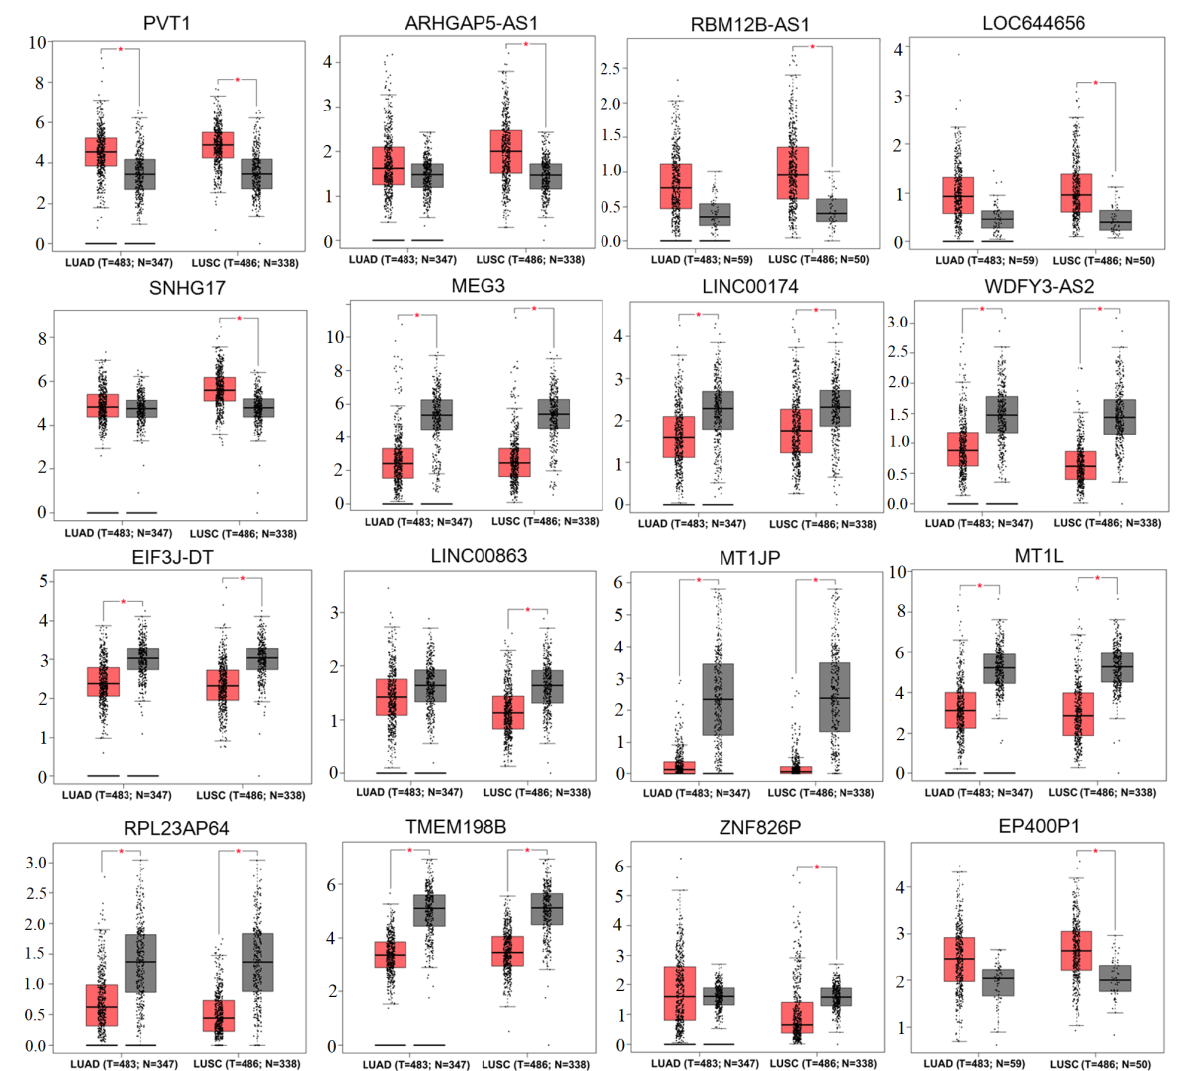
Figure 4. Validation of the expression levels of lncRNAs and pseudogenes in lung cancer. N = 50 or 59 indicates the controls are match TCGA normal data; N = 338 or 347 indicates the controls are match TCGA normal and GTEx data; asterisk (*) indicates the statistical significance at the threshold of |log 2 FC| > 0.5 and p -value < 0.05.